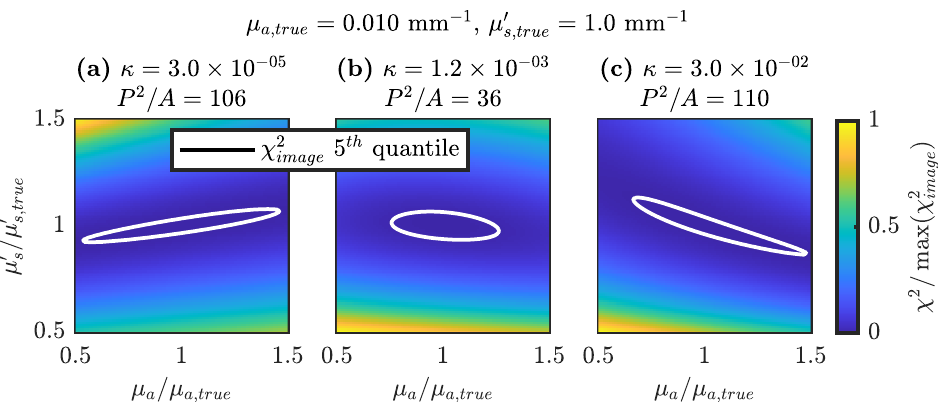
Figure 5. Three examples of the χ 2 (Equation (28)) space shape for different κ s. The shape of cost space is determined by the shape of an iso-line and its ratio of P squared divided by A ( P 2 / A ) which has a minimum possible value of 4 π (in the case of a circle). Iso-lines are the 5th quantile of all χ 2 values in each image and are meant to represent the overall shape of χ 2 space. For all axes, χ 2 , the µ a , and the µ (cid:48) s are normalized. ( a ) κ = 3 × 10 − 5 and P 2 / A = 106. ( b ) Optimal value of κ for the true optical properties used here found by minimizing P 2 / A , resulting in κ = 1.2 × 10 − 3 and P 2 / A = 36. ( c ) κ = 3 × 10 − 2 and P 2 / A = 110. Acronyms and Symbols: Cost ( χ 2 ), scaling factor ( κ ), Perimeter ( P ), Area ( A ), absorption coefficient ( µ a ), and reduced scattering coefficient ( µ (cid:48) s